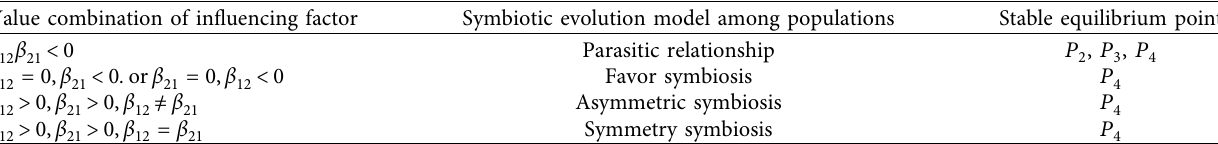
Table 2: Symbiotic evolution model and equilibrium point of the